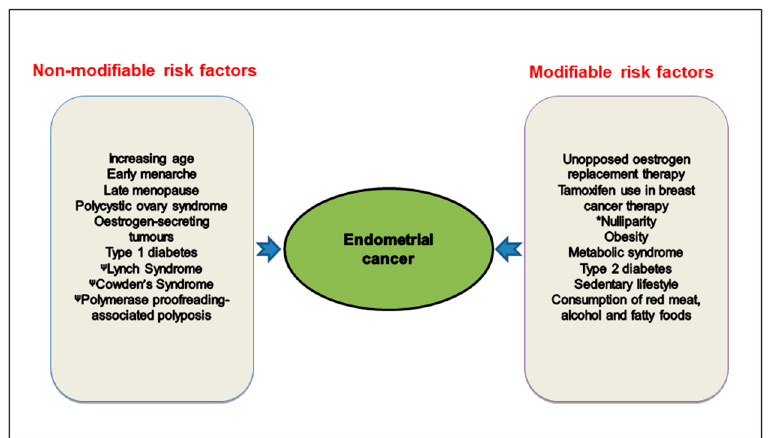
Figure 1. Epidemiological, genetic, clinical, lifestyle and dietary risk factors for the development of endometrial cancers. Two distinct pathways are depicted in which non-modifiable and modifiable risk factors are listed. * Nulliparity is included as modifiable risk factor because pregnancy can reduce the risk of EC development. It could also conceivably be included as a non-modifiable risk factor, since some women are unable to conceive. ψ Familial genetic mutations are also risk factors for EC and are associated with Lynch syndrome, Cowden’s syndrome, and Polymerase proof-reading polyposis (see Figure 5).